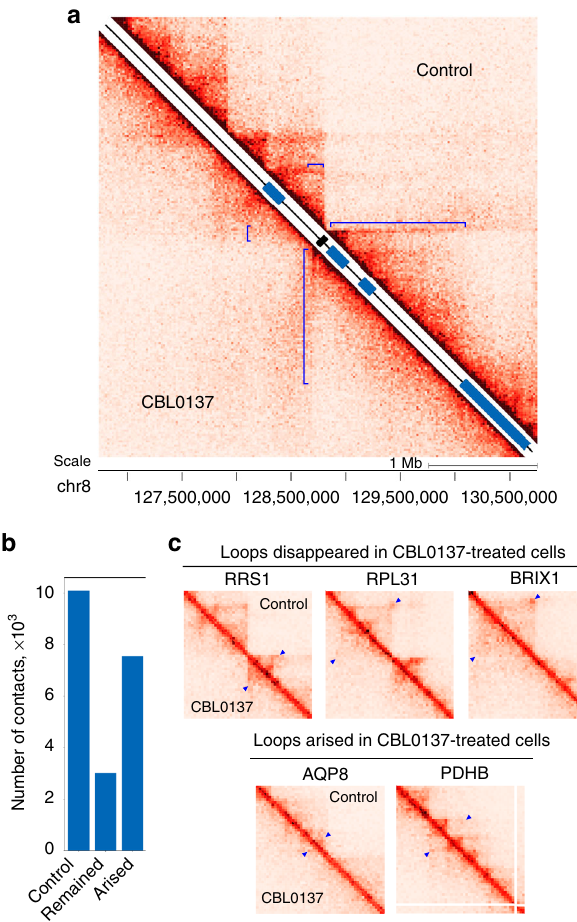
Fig. 4 CBL0137 disturbs the chromatin loops that juxtapose distant genomic elements. a Hi-C maps showing that CBL0137 treatment suppressed the spatial interactions of the MYC gene (black rectangle) with distant enhancers (blue rectangles, presented according to ref. 12 ). The regions of the Hi-C maps representing the spatial juxtaposition of MYC and distant enhancers are shown by blue square brackets. The size of the genomic region is 4 Mb. b Bar plots showing the total number of annotated distant (40 kb or longer) spatial contacts in control cells, the number of distant contacts preserved after CBL0137 treatment, and the number of spatial contacts originated de novo as the result of CBL0137 treatment. c Representative sections of HiC-maps showing chromatin loops demolished by CBL0137 treatment and chromatin loops originated de novo as the result of CBL0137 treatment. The signals from the loop bases are at the top of the blue triangles. The 1 Mb-long regions presented on the heatmaps are centered around genes indicated above the